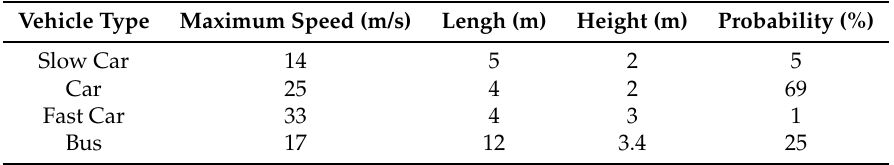
Table 3. Vehicle types and associated probability in urban scenarios. SUMO parameters.